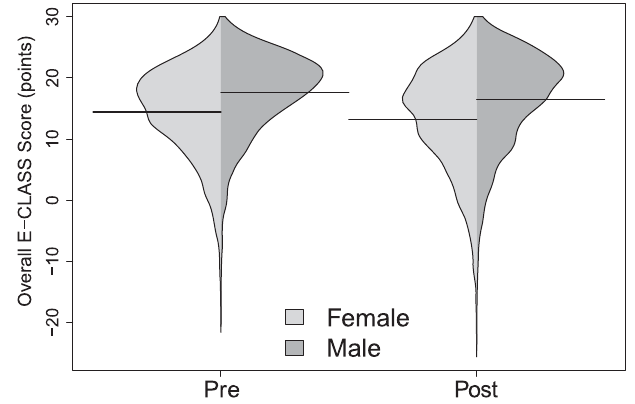
FIG. 1. Violin plots showing the distribution of overall pre- and postinstruction E-CLASS scores for men and women in the full, aggregate data set ( N ¼ 7013 ). Solid lines indicate the mean for each distribution. Differences between the distributions for men and women are statistically significant for both pre- and post-tests (Mann-Whitney U, p ≪ 0 . 01